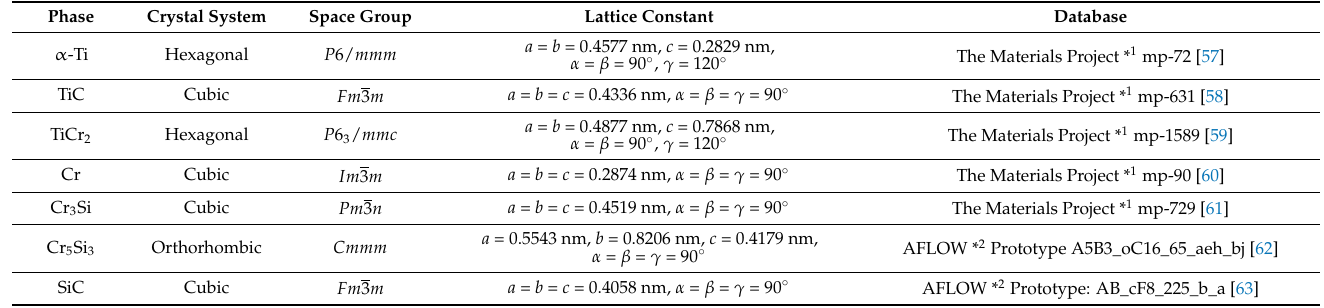
Figure 9. EDS line profile of chemical composition and constituent phases along the analyzed lines (bule-green) in unirradiated Ti-Cr multilayer coating. The analyzed lines includes ( a ) Ti, Ti-Cr mixed, and Cr layers and ( b ) Ti-Cr mixed, Cr, diffused Cr-SiC interface, and CVD SiC layers. Table 1. Information for phase identification by SAD analysis using ReciPro